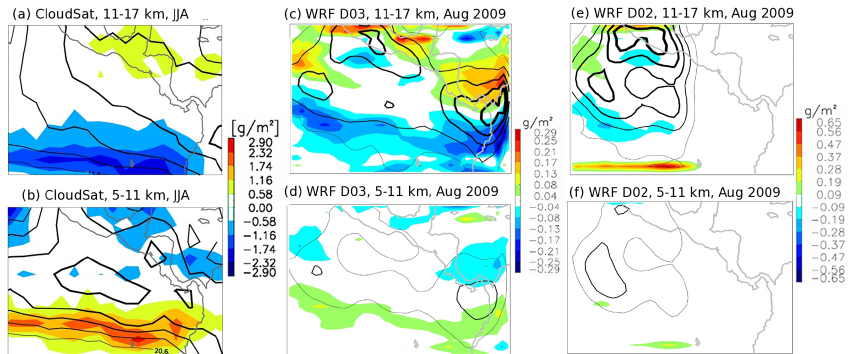
Figure 6. Climatological (cid:49) IWP (color shades) derived from CloudSat at 77 ◦ view angle during JJA, 2007–2010 for ice clouds within 11– 17km (a) and 5–11km (b) , and the same variable derived from WRF D03 (c and d) and D02 (e and f) domains at 77 ◦ view angle. The black contours mark the mean IWP integrated along the nadir view within the corresponding altitude range. Note that the magnitude of (cid:49) IWP from WRF run is much smaller than that from the CloudSat observations.